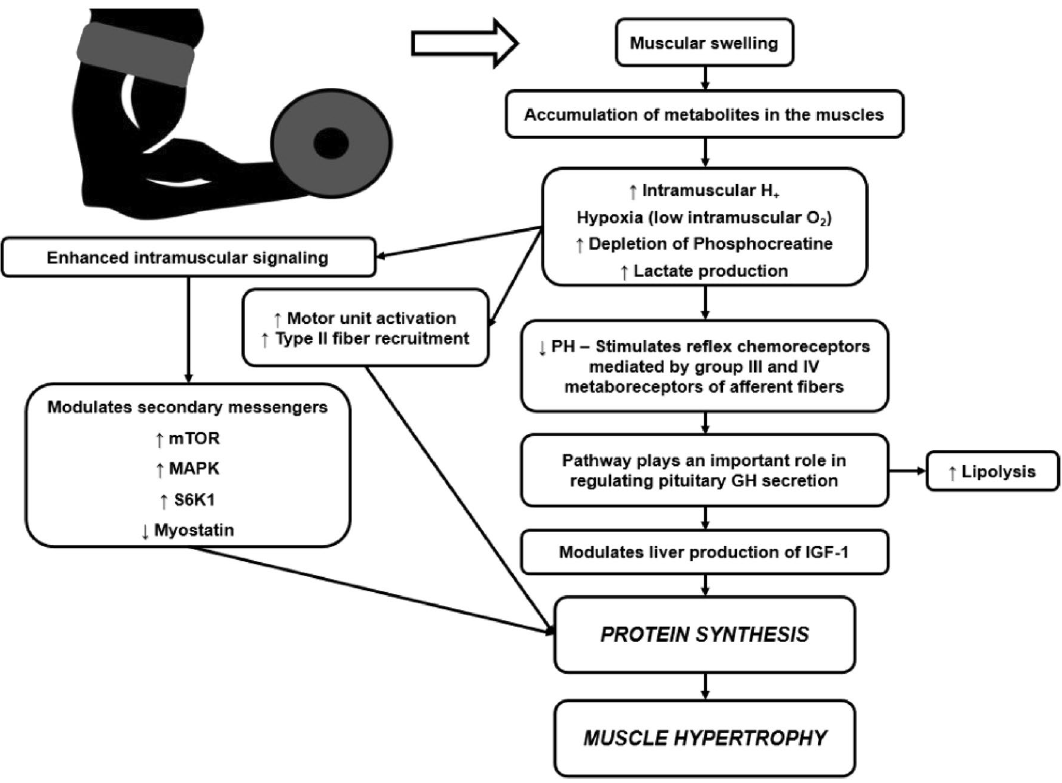
Figure 1. Mechanisms responsible for the efficiency of the RTBFR. H: hydrogen; O 2 : oxygen; GH: growth hormone; IGF-1: insulin-like growth factor I; mTOR: mammalian target of rapamycin; MAPK: